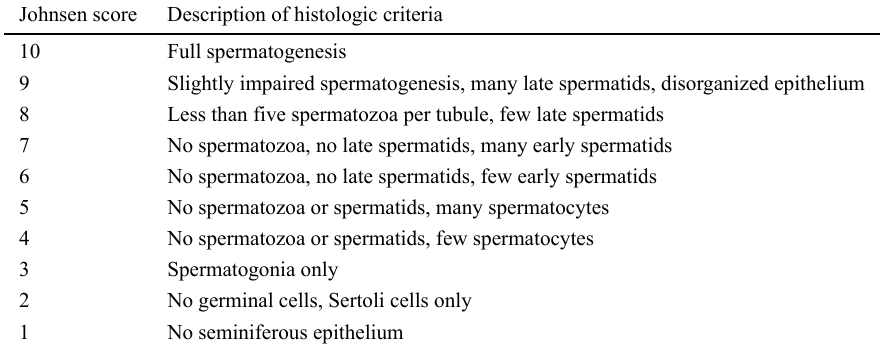
Table 1. Johnsen scoring system for testicular damage